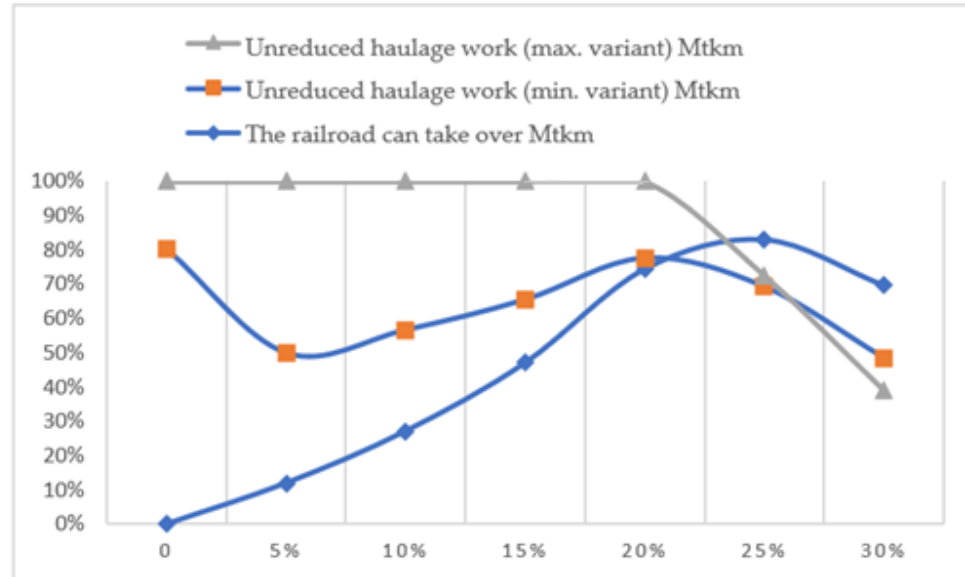
Figure 4. Analysis of the absorption of the goods hauled in road transport by rail.